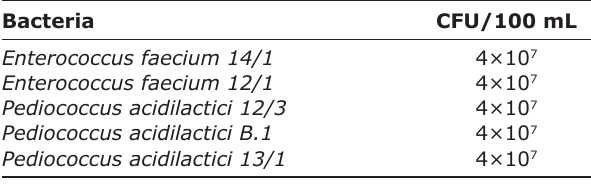
Table-1: Composition of study probiotic mixture